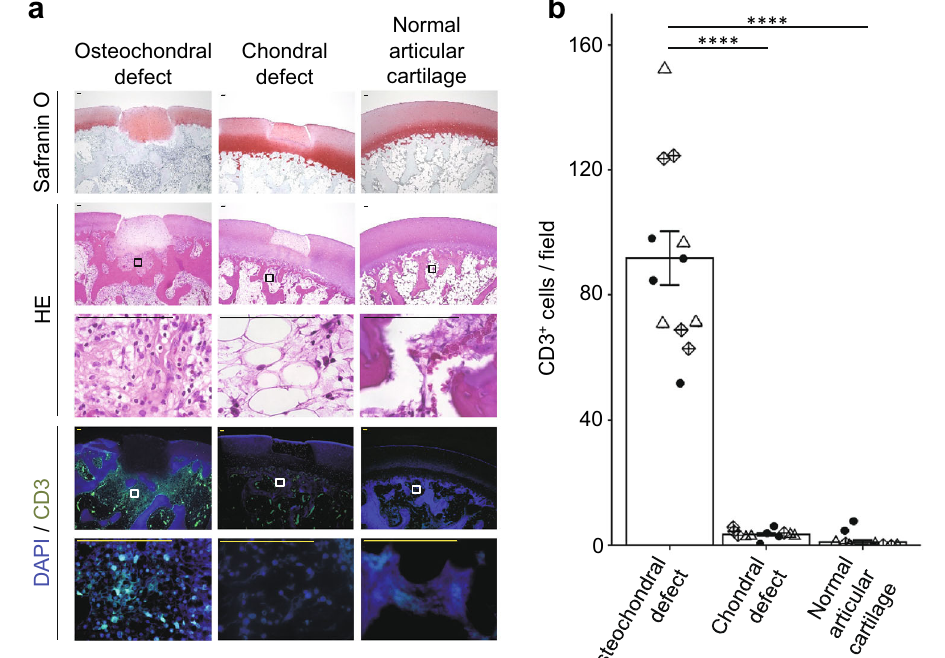
Fig. 2 | Analysis of immune reactions following allogeneic transplantation of cyiPS-Cart into chondral defects in the knee joints 4 weeks after transplanta- tion. a Semi-serial histological sections were stained with safranin O or HE, or immunostained for CD3. Scale bars, 100 µ m. b The number of CD3+ cells per microscopic fi eld was determined. Four fi elds were used for each monkey. Three